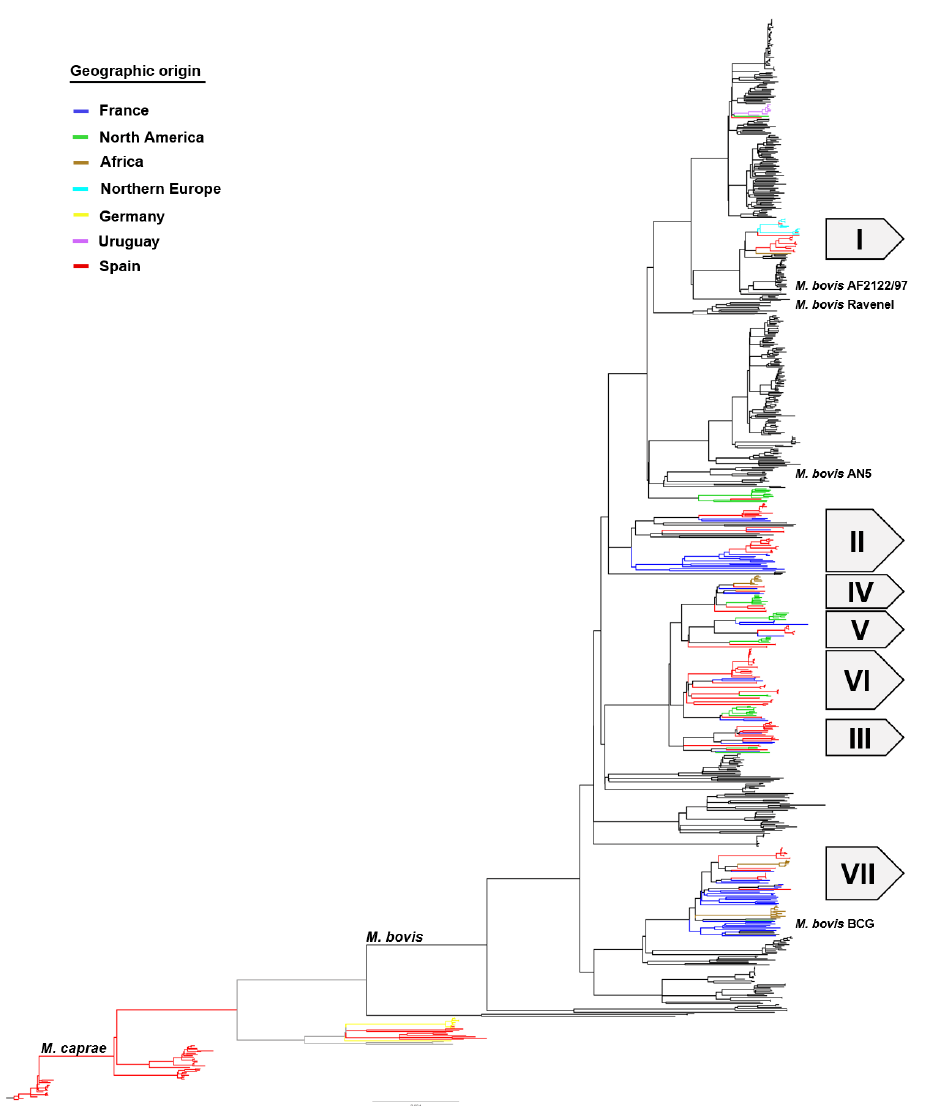
Figure 4. Global phylogenetic structure of M. bovis isolates representing a worldwide data set. M. caprae is used as the